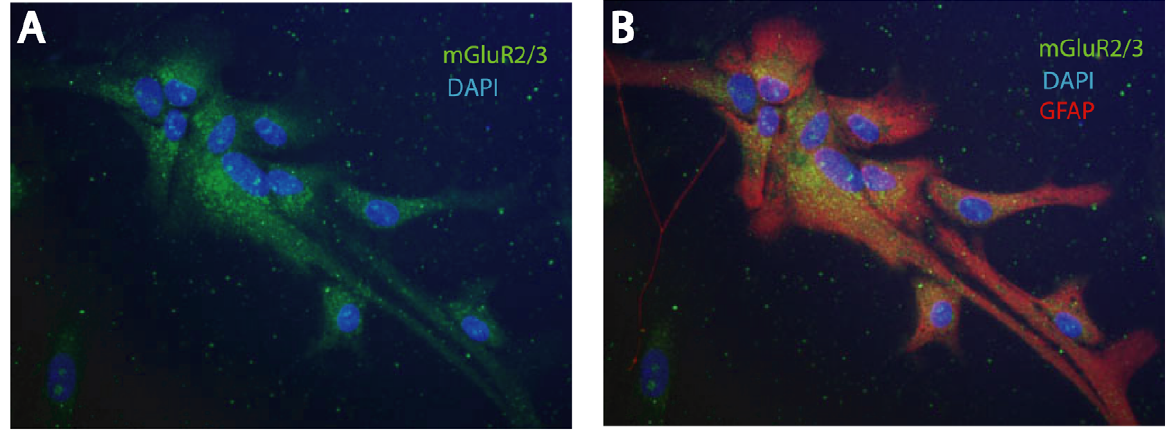
Figure 1. mGluR3 expression in astrocytes. Immunolabeling for mGluR2/3 (green), GFAP (red) and DAPI (blue) done on rat primary astrocytes. (A) Immunolabeling for mGluR2/3. Picture B shows mGluR2/3 and GFAP merged images (yellow).